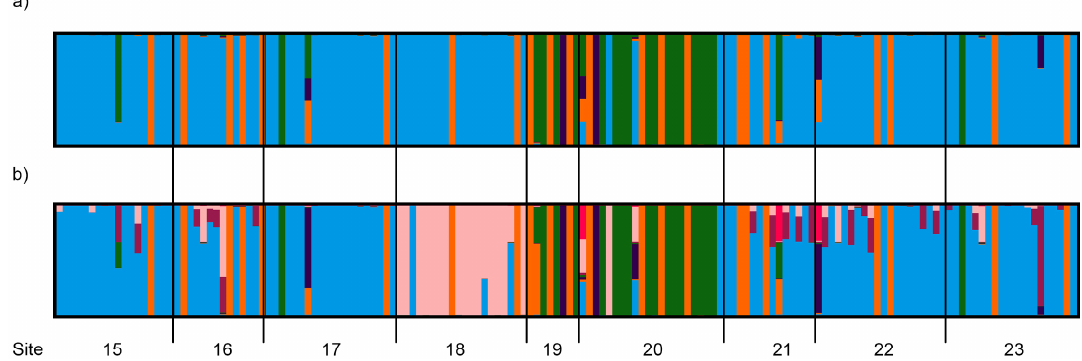
Figure 5. Clumpak output summarising 10 replicate fastStructure runs of ( a ) K = 4 and ( b ) K = 7 for Sclerolaena napiformis individuals from central (sites 15, 16, 17, 18, 21, 22, and 23) and northeast (sites 19 and 20) regions